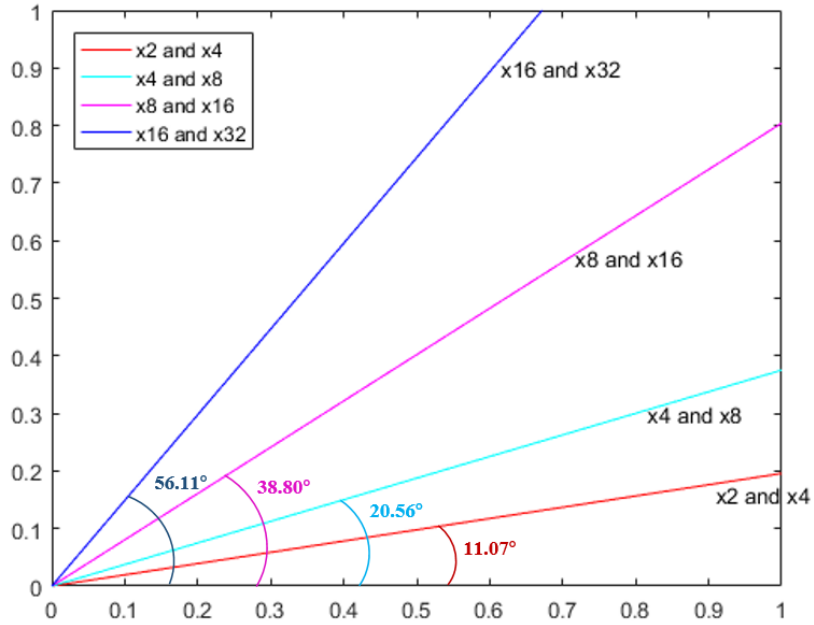
Figure 7. Cosine angle between adjacent down-sampled levels of Set5